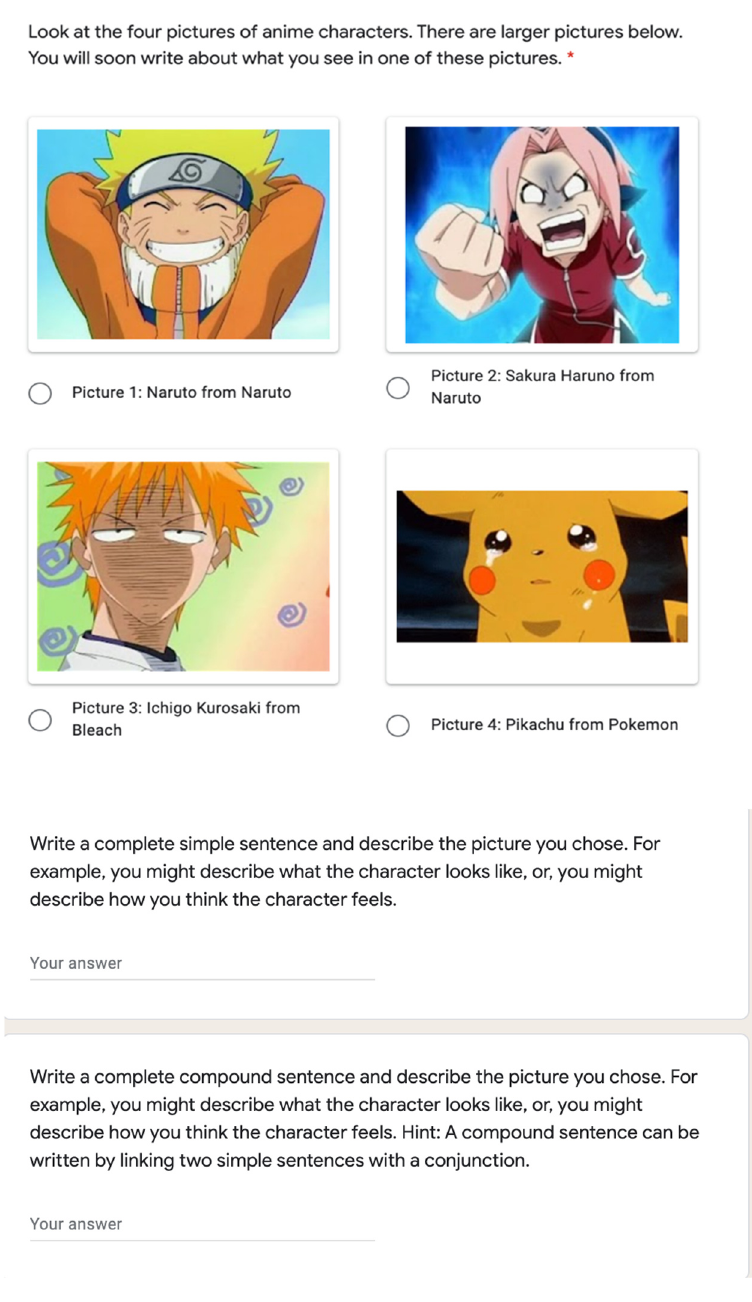
Figure 11. Example of a writing assessment item. Note: * indicates that a test-taker’s response is required.